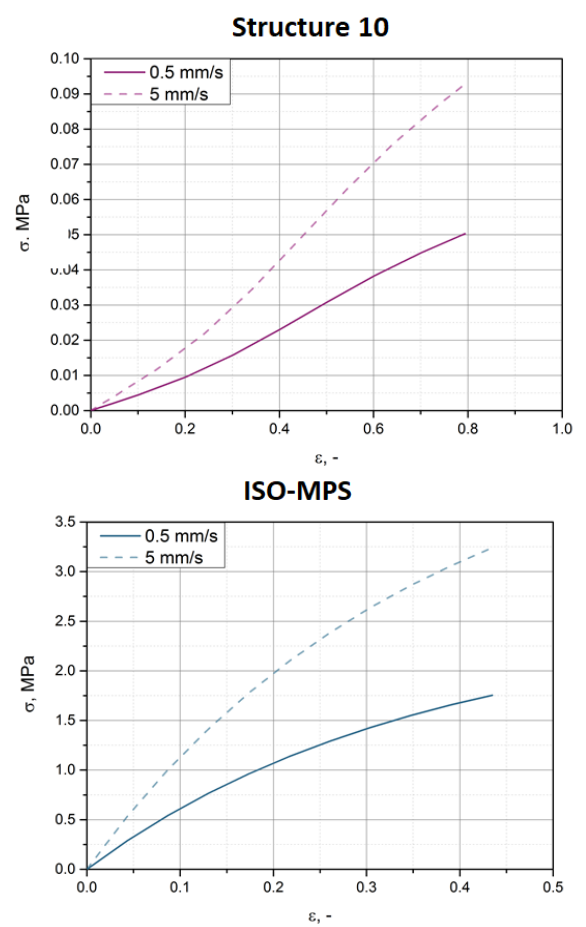
Figure 9. Illustration of visco-elastic behaviour of Str. 10 (top) and ISO-MPS